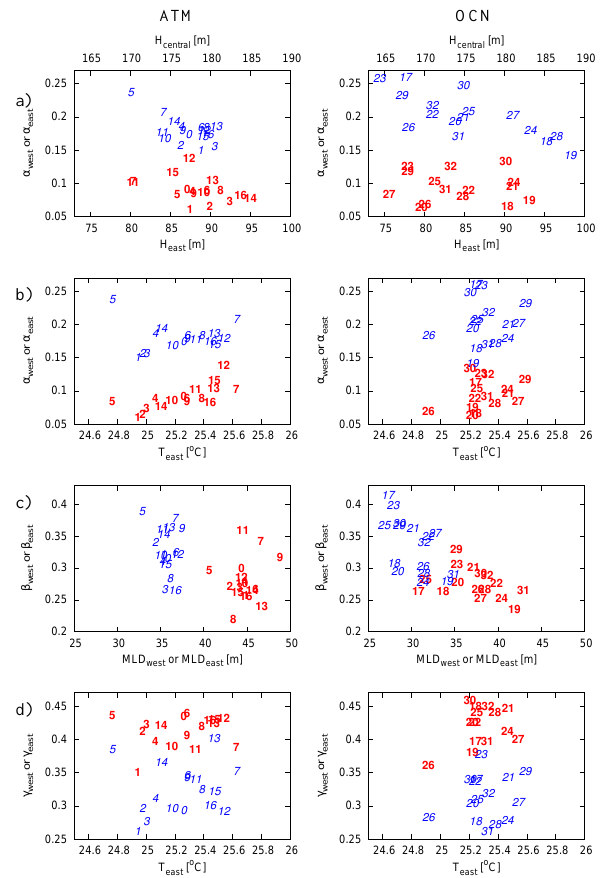
Fig. 5. Fitted SST-equation parameters as in Eq. (1) and Fig. 2 for all members, indicated by the numbers. Red are the values for the West Pacific, blue for the East Pacific. The left column shows the ATM ensemble, the right column shows the OCN en- semble. (a) Response of SST to thermocline anomalies, α [0.1K m − 1 month − 1 ] versus mean thermocline depth. The labels for H central are plotted on top of the figures. (b) α versus mean East Pacific temperature. (c) SST response to wind stress anomalies, β [100KPa − 1 month − 1 ] versus mean mixed layer depth. (d) damp- ing time on SST, γ [month − 1 ] versus mean East Pacific tempera- ture.